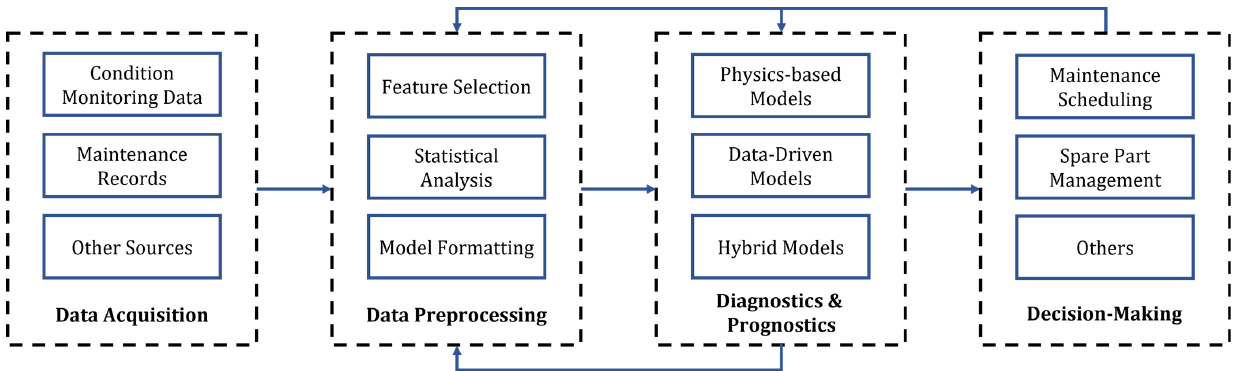
Figure 1. Example of the main stages in a PHM framework.